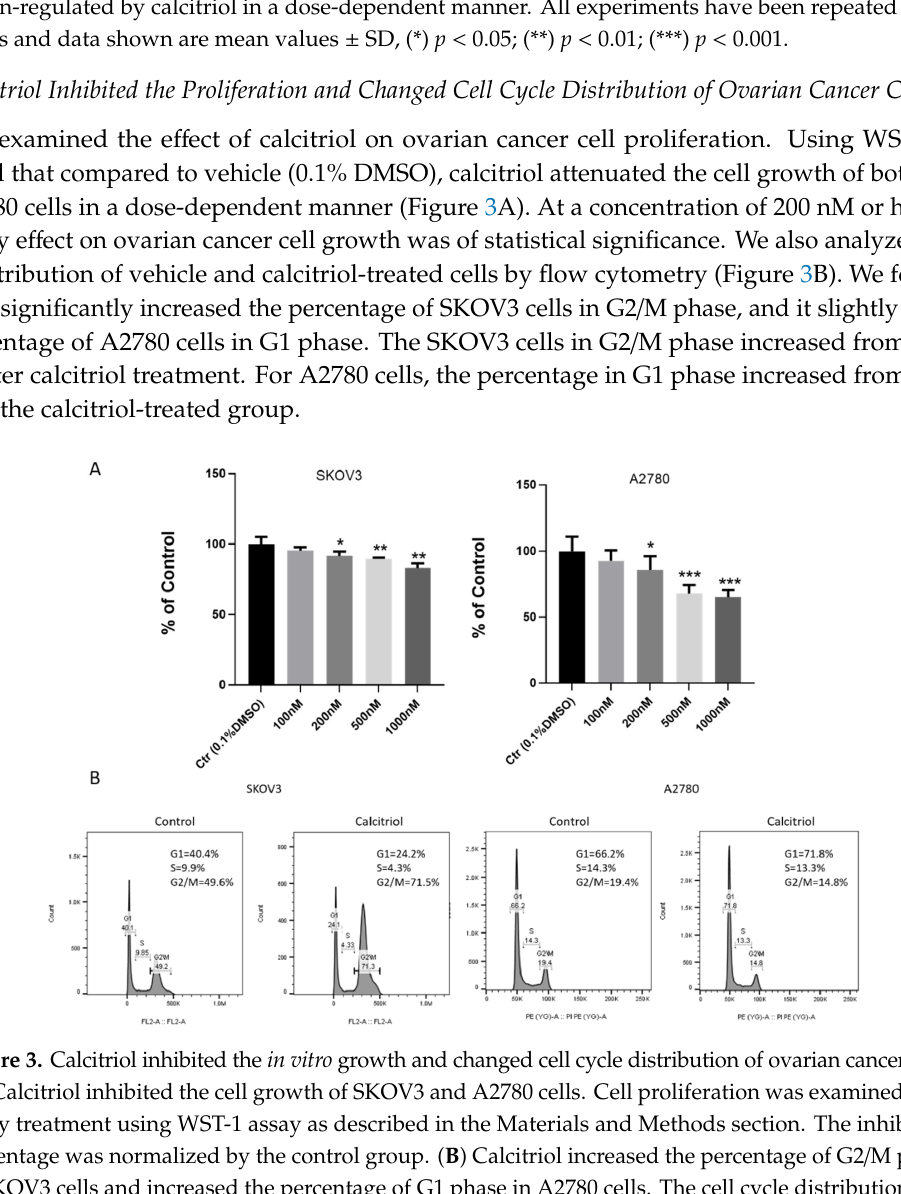
Figure 3. Calcitriol inhibited the in vitro growth and changed cell cycle distribution of ovarian cancer cells. ( A ) Calcitriol inhibited the cell growth of SKOV3 and A2780 cells. Cell proliferation was examined after 3-day treatment using WST-1 assay as described in the Materials and Methods section. The inhibition percentage was normalized by the control group. ( B ) Calcitriol increased the percentage of G2 / M phase in SKOV3 cells and increased the percentage of G1 phase in A2780 cells. The cell cycle distribution was analyzed using flow cytometry. All experiments have been repeated three times and data shown are mean values ± SD, (*) p < 0.05; (**) p < 0.01; (***) p <